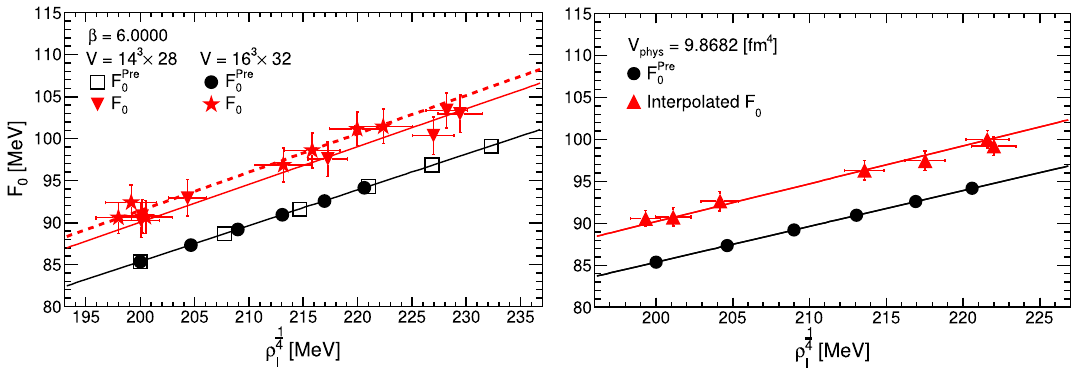
Fig. 14 Comparisons of the decay constant F 0 at the chiral limit of the configurations of β = 6 . 0000, V = 14 3 × 28 and V = 16 3 × 32 (left) and the interpolated results at the continuum limit (right) with the predictions F Pre . In the left figure, the black full, the red full, and the red 0